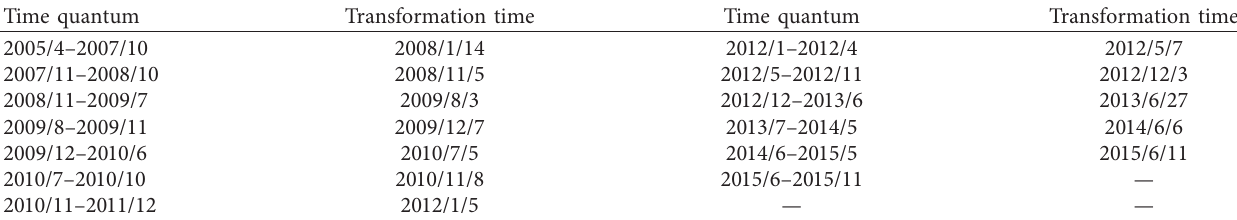
Table 3: Jump transformation time of CSI 300 index returns.